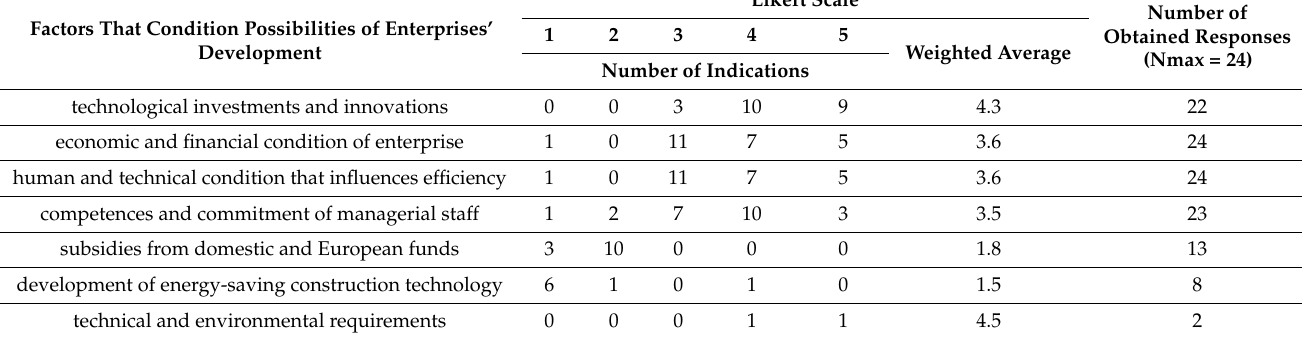
Table 4. Factors that condition possibilities of development of design and construction enterprises of PV farms—Likert scale